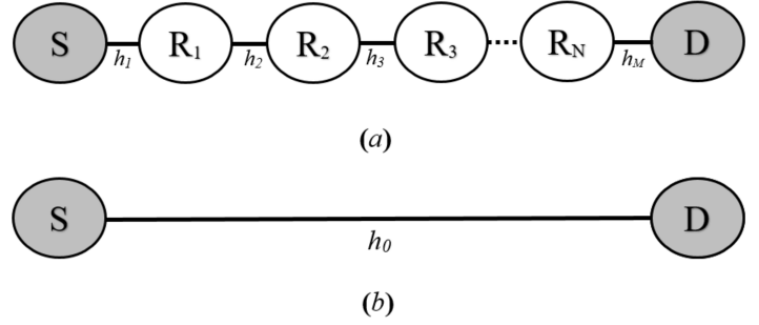
Figure 3. Basic block diagrams of the proposed VLC systems, ( a ) with N intermediate VLC relays and ( b ) with a direct VLC